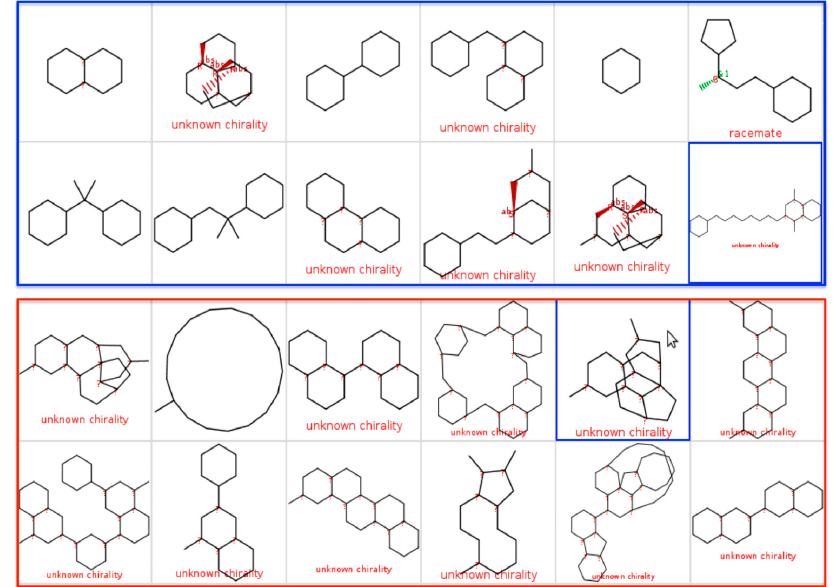
Figure 6. Comparison of top twelve scaffolds from the CRAD and NAA datasets. The top twelve Murcko scaffolds from currently registered antimalarial drugs (CRAD) are shown in the top blue panel. The top twelve Murcko scaffolds from the highly active natural products with in vitro antiplasmodial activity (HA) are shown in the bottom red panel. There were no similar scaffolds between the two datasets.